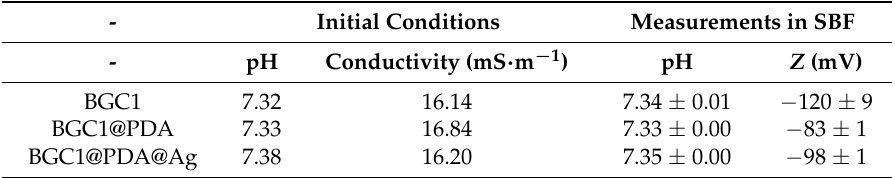
Table 2. Surface zeta potential of the different samples investigated (measurements in simulated body fluid